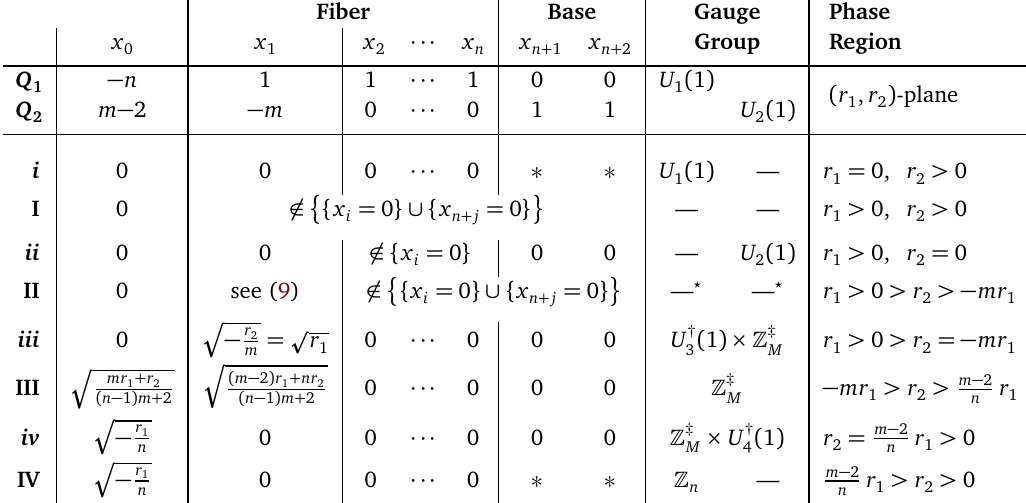
( 1 ) completely, while x (cid:54) = 0 breaks 2 0 || x | = 0. This then 1 0 ) : f ( x ) = 0 } is fibered orbifold of { ( x , ··· , x n n 1